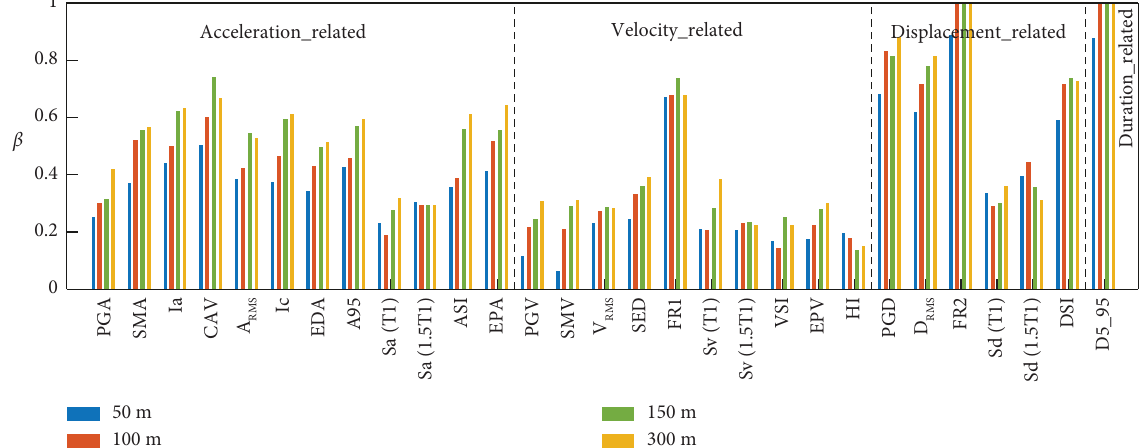
Figure 9: Efciency comparison of 29 candidate IMs against FOS for the slopes with diferent mining depths.